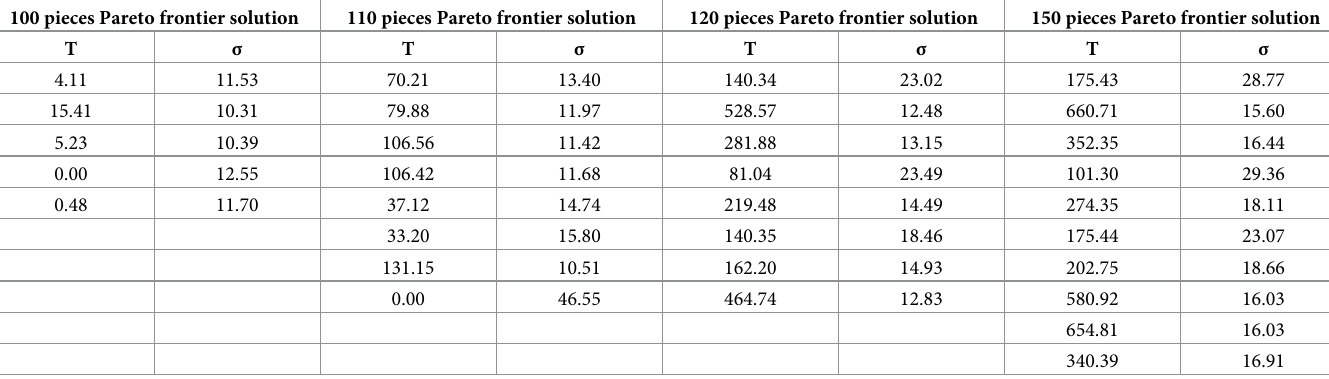
Fig 4, NSGA-II-EDSP, NSGA-II-KES, and NSGA-II-QKES show good range search ability, and their search ability is relatively stable, with an average improvement of 13.07%, 15.22% and 17.55% respectively. The quality of the solution is one of the main indexes to evaluate the performance of the algorithm. In this paper, the error ratio index (ER) is used to express the difference between Table 4. Pareto frontier data table after solving each imitation case. 100 pieces Pareto frontier solution 110 pieces Pareto frontier solution 120 pieces Pareto frontier solution 150 pieces Pareto frontier